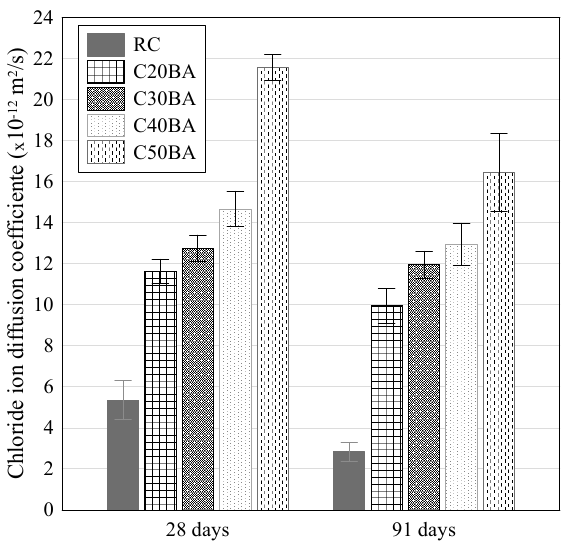
Figure 10. Chloride diffusion coefficient at 28 and 91 days.